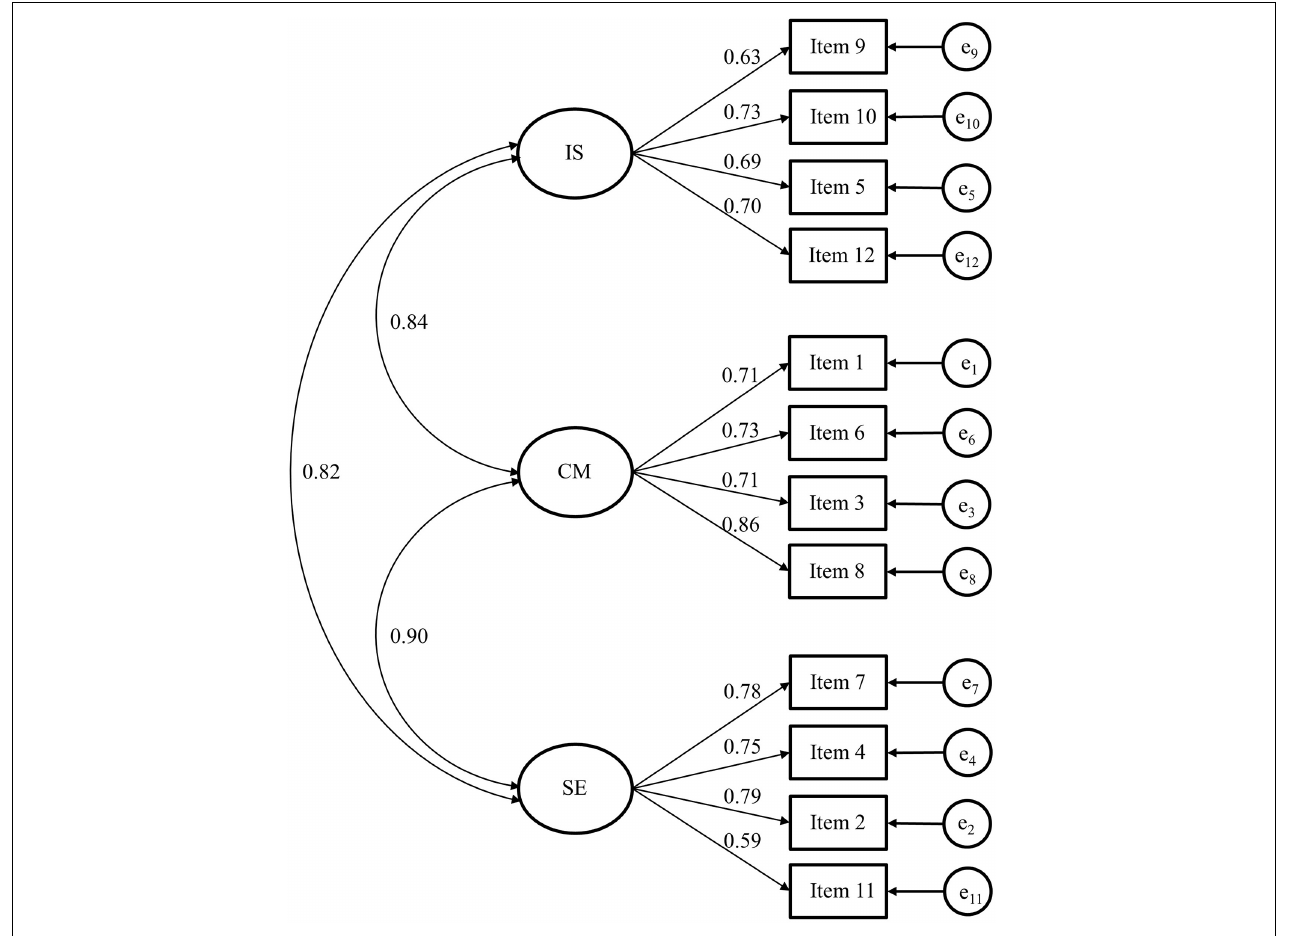
FIGURE 1 | Factor structure of the TSES (Spanish version). The number of the items corresponds to the order followed in the Spanish TSES (see Table 2 ). IS, efficacy for instructional strategies; CM, efficacy for classroom management; SE, efficacy for student engagement.